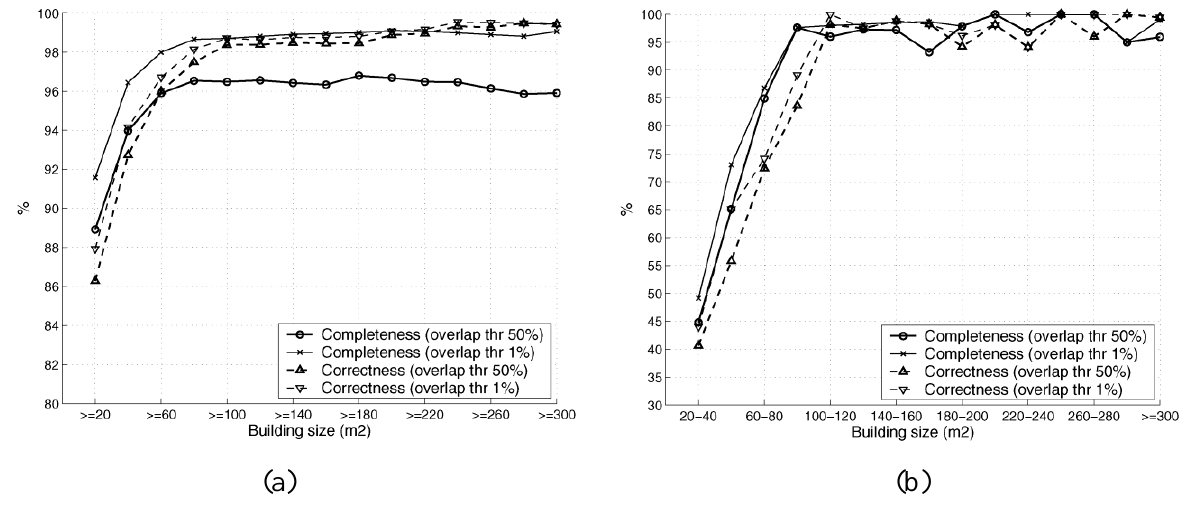
Figure 6. Building-based accuracy estimates for the building detection results as a function of building size. (a) Estimates for all buildings larger than the X axis value. (b) Estimates for buildings in the size range given by the X axis values. An overlap of either 50% or 1% between reference and detected buildings was required to consider a building correctly detected.